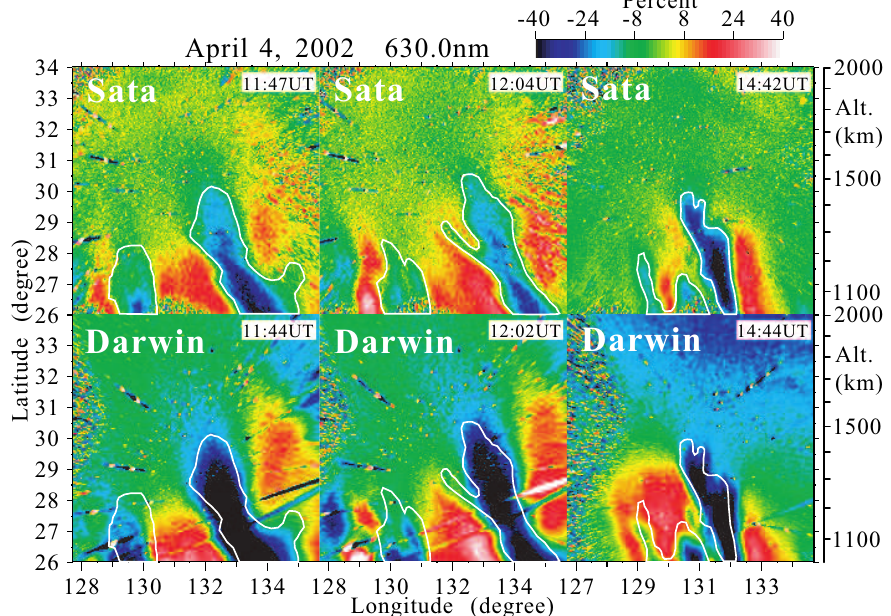
Fig. 5. Comparison of the plasma bubble structures observed in the 630.0-nm airglow images at Sata, Japan, and Darwin, Australia, on 4 April 2002, in the same format as that in Figs. 3 and 4. The airglow images at Darwin (bottom three panels) are those converted to the Northern Hemisphere using the IGRF magnetic field model. The white curves in the top three panels show envelopes of the bubble structures at Sata. The same curves are indicated in the bottom three panels to compare the bubble structures between Sata and Darwin. The two lines seen at the bottom right of the Darwin images at 11:44 UT and 12:02 UT are airplane trajectories.